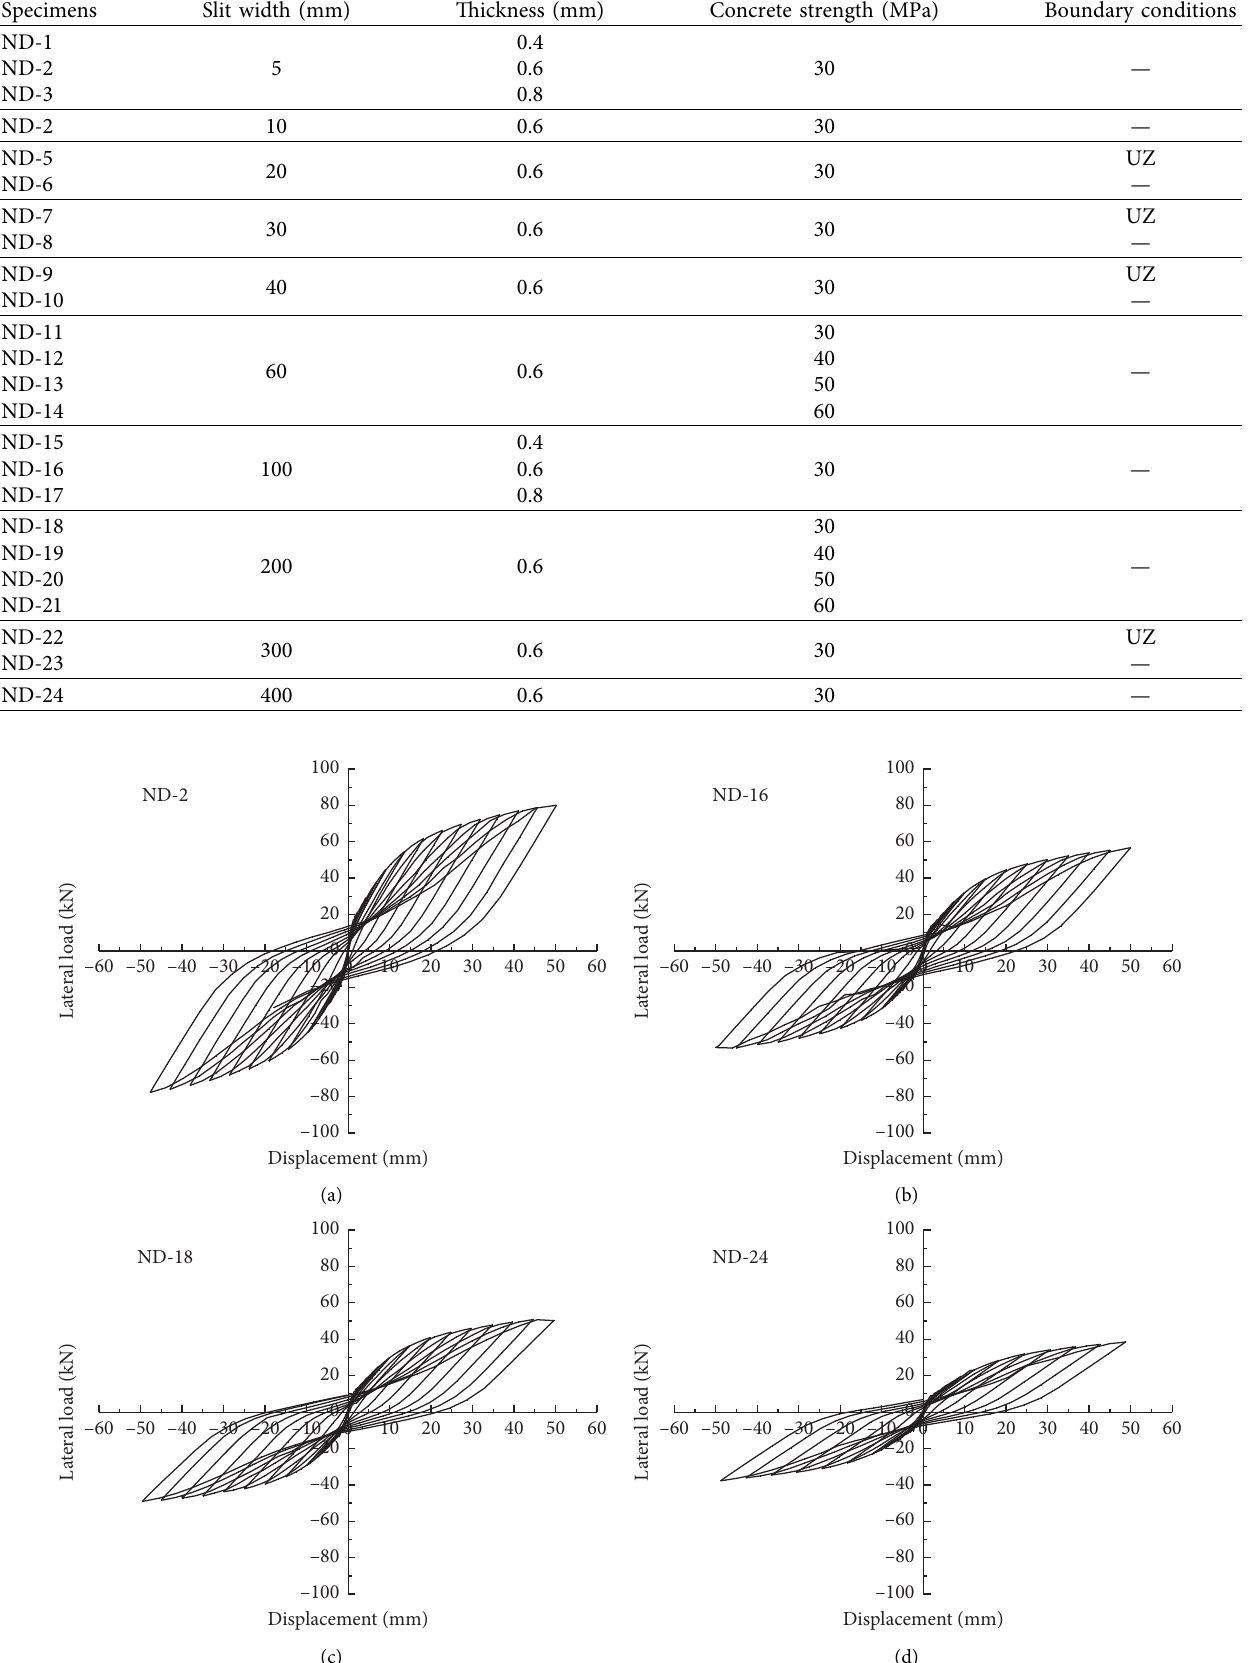
Table 4: Influence parameters.